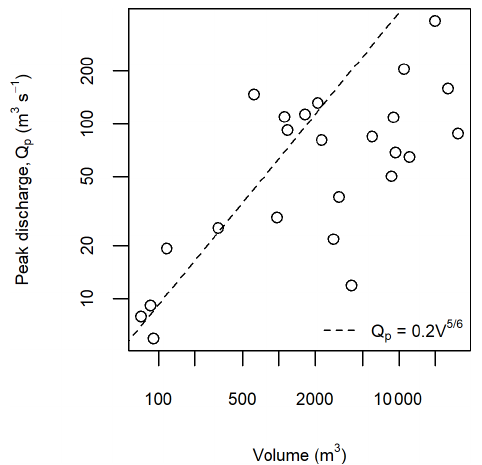
Figure 4. Peak discharge versus volume for the cases summarized in Table 2, with the dashed line indicating the values for Eq. (5) with c = 0 .